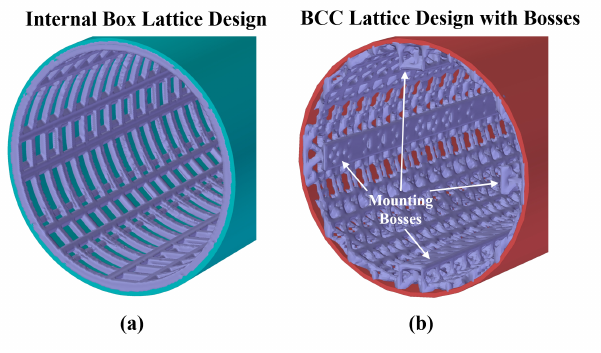
Figure 13. Internal lattice designs for electronics housing section where ( a ) is a simple lattice and ( b ) is a BCC lattice with integrated mounting